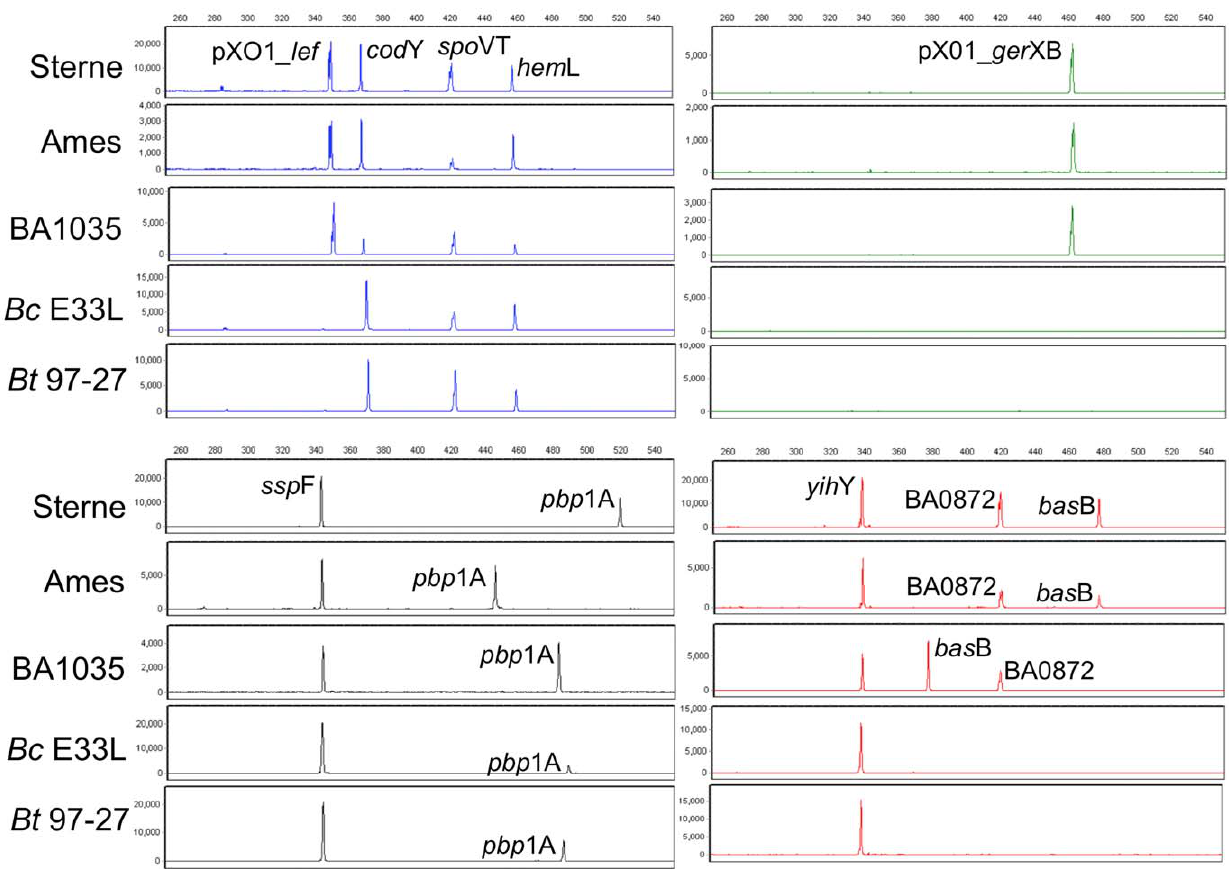
Figure 2. 10-plex PCR profiles generated from representative Ba and Ba NN strains. As input to PCR, 100 copies of template Ba strains Sterne, Ames, and BA1035; and 1000 copies of template Ba NN strains Bc E33L and Bt 97-27, were used. The FAM (blue), JOE (green), TMR (black) and ROX (red) labeled products are aligned to illustrate amplicon sizes from the set of five strains. As expected, all 10 loci were amplified in the 3 Ba strains; only 6 of 10 loci were observed in Ba NNs. The bas B and pbp 1A amplicons allow discrimination between strains Ames, Sterne, and BA1035; pbp 1A fragment length also distinguishes Bc E33L from Bt 97-27. X-axes show fragment size in base pairs and Y-axes relative fluorescence units (rfu).